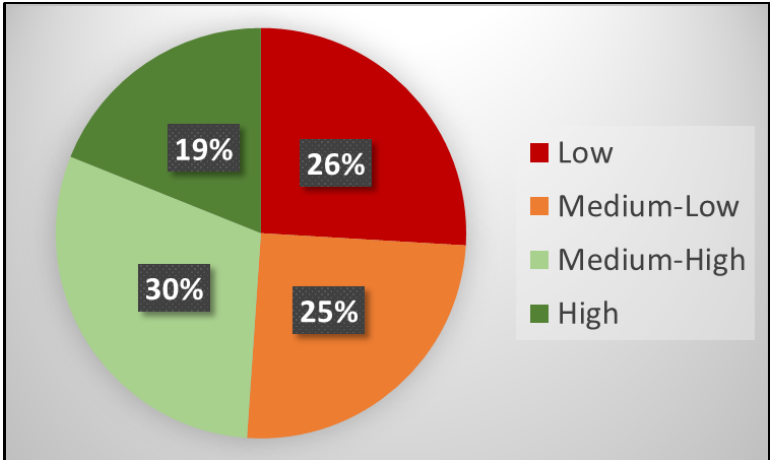
Figure 10. Hotel Guests’ Energy -Use Behavior Opportunity Level.